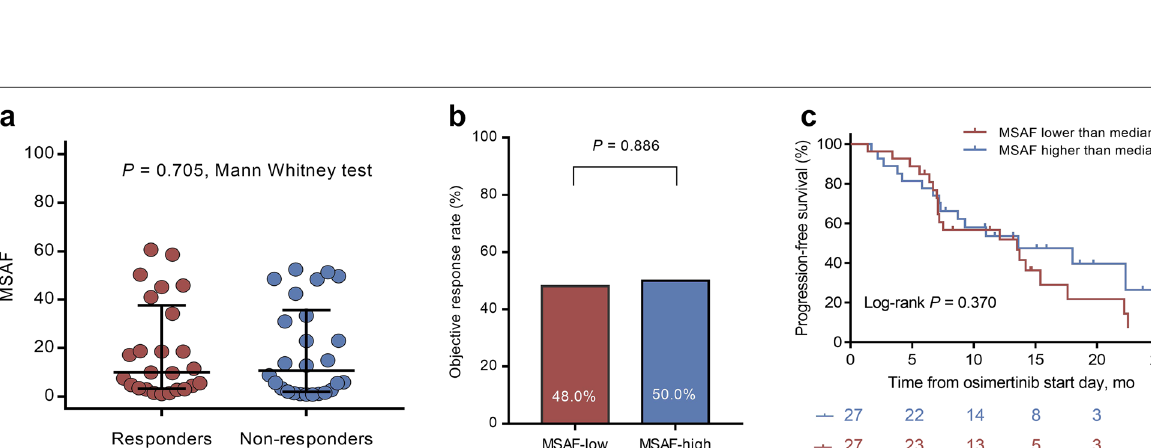
Association between T790M RMA and osimertinib (Fig. 4b). At the extremes, patients with the highest treatment outcomes T790M RMP (Q4) had a 71% reduced risk of disease Similarly, we analyzed the T790M RMA, and found a progression or death compared with patients with low- positive association between T790M RMA quartiles est T790M RMP (Q1) (HR 0.29, 95% CI 0.10–0.81, = and ORRs; however it was not statistically significant P 0.018). To facilitate practical application of our = ( P for trend 0.063; Fig. 5a). And although there was a findings, we determined the optimal T790M RMP cut- = statistically significant association trend towards PFS ( P off for response using a ROC-determined value of 0.24 for trend 0.043), it is noteworthy that the third quar- (area under the curve 0.761) (Fig. 4c). Above this = = tile (Q3) of RMA showed the greatest risk reduction cut-off (n 35), patients presented an ORR of 65.6% = and median PFS of 17.6 months, whereas below this cut-off (n 19), patients presented an ORR of 21.1% = Fig. 5b). ROC analysis determined that the optimal ( P 0.002; Fig. 4d) and median PFS of 7.2 months (log- = RMA cut-off for response was 0.3 (Fig. 5c). Above this rank P 0.002; Fig. 4e). =